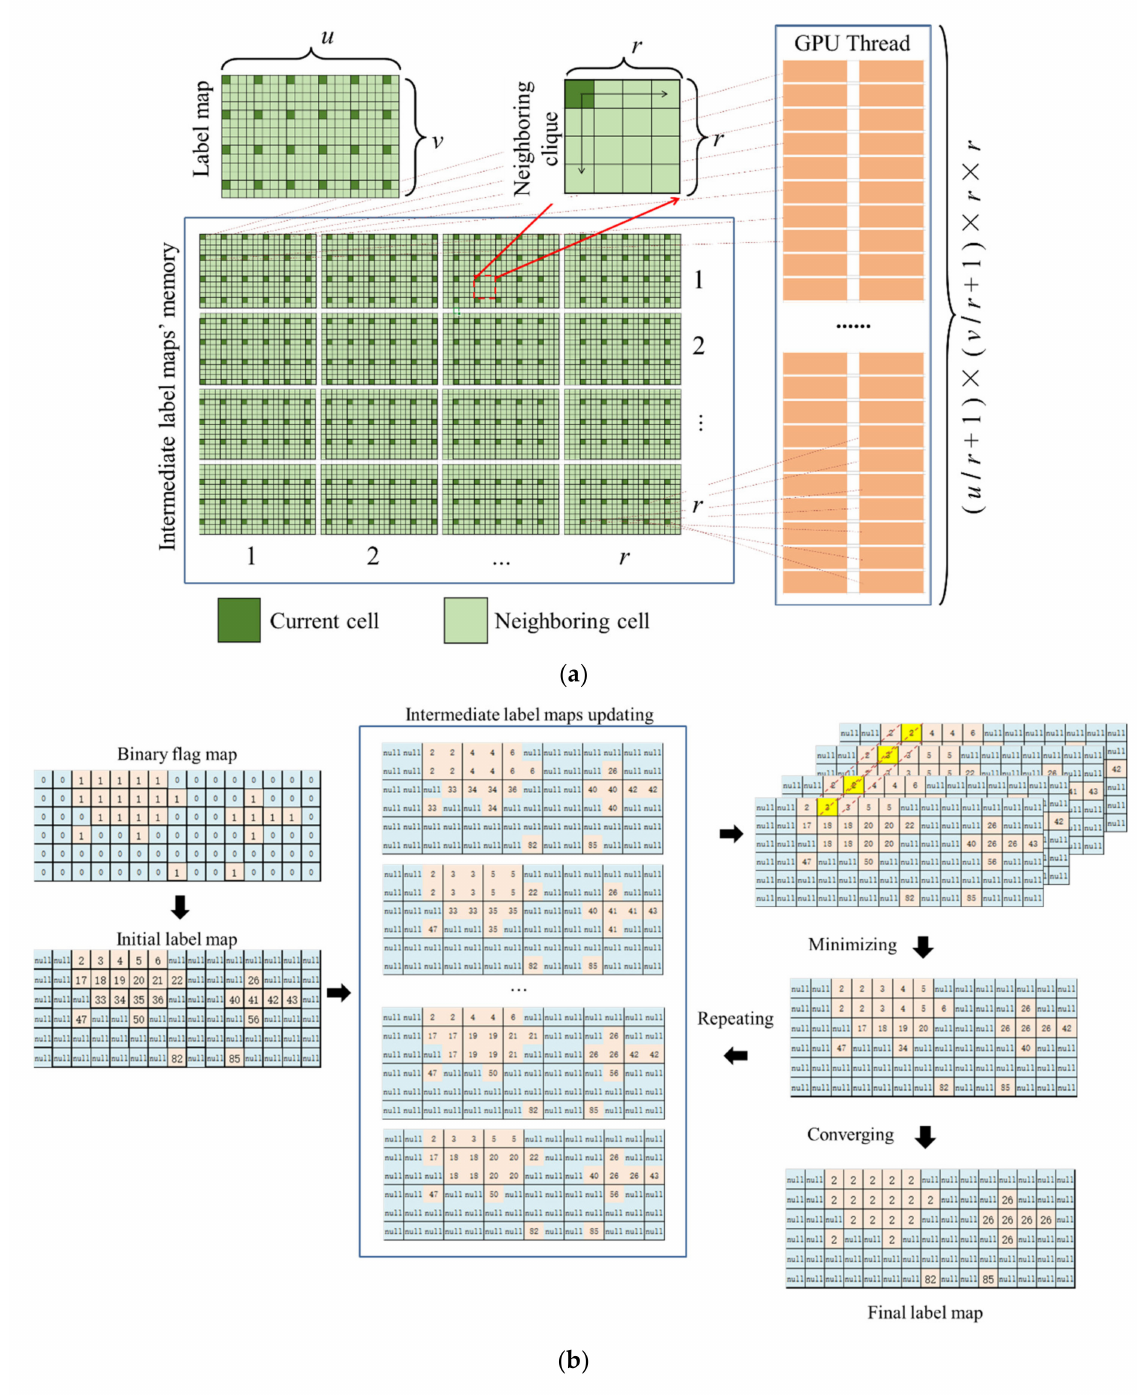
Figure 11. Proposed data independency solution of labeling process: ( a ) intermediate label map updating and thread allocating; ( b ) intermediate label maps merging process with independent